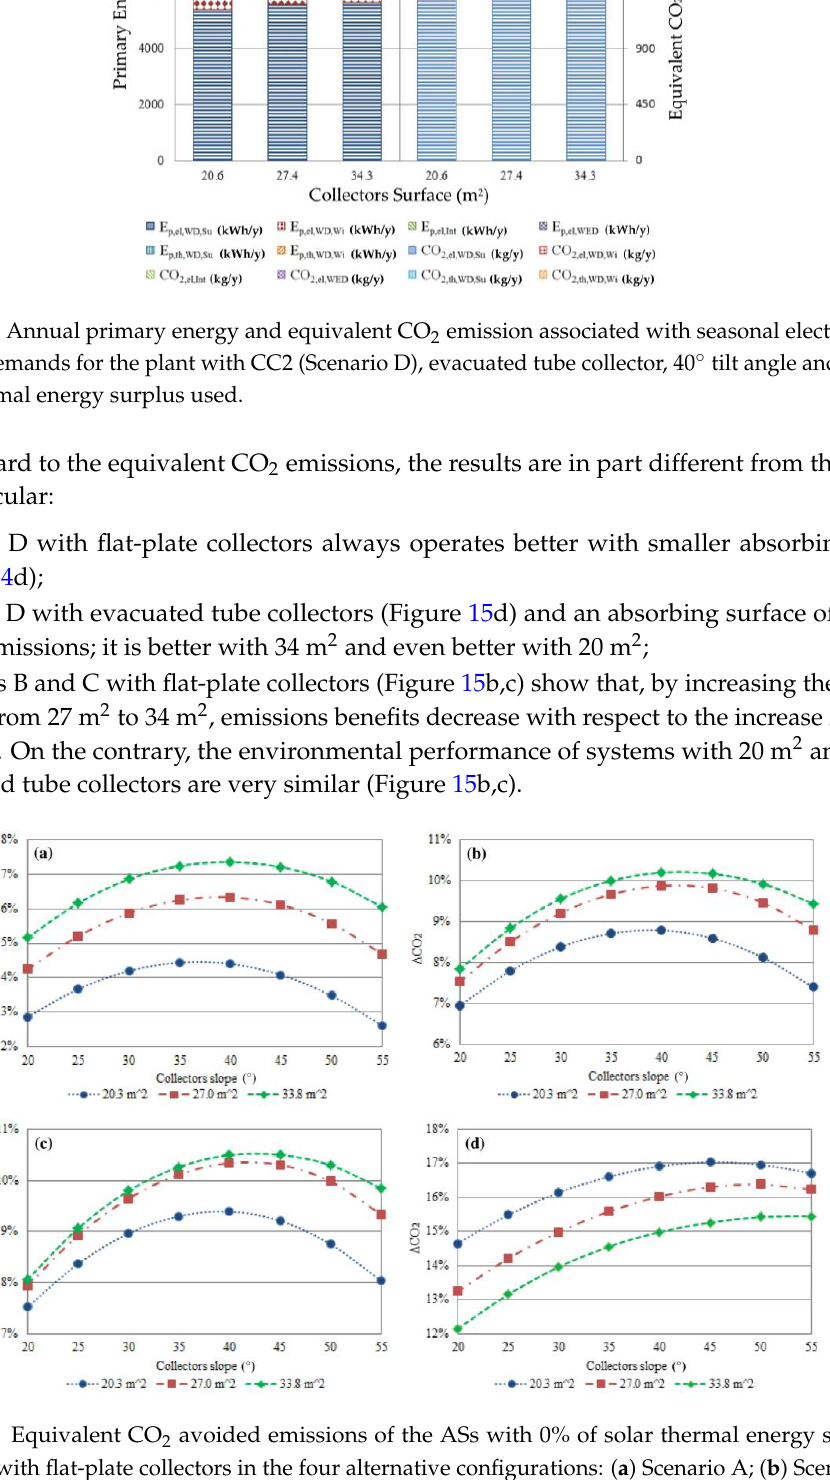
Figure 14. Equivalent CO 2 avoided emissions of the ASs with 0% of solar thermal energy surplus used and with flat-plate collectors in the four alternative configurations: ( a ) Scenario A; ( b ) Scenario B; ( c ) Scenario C; and ( d ) Scenario D.